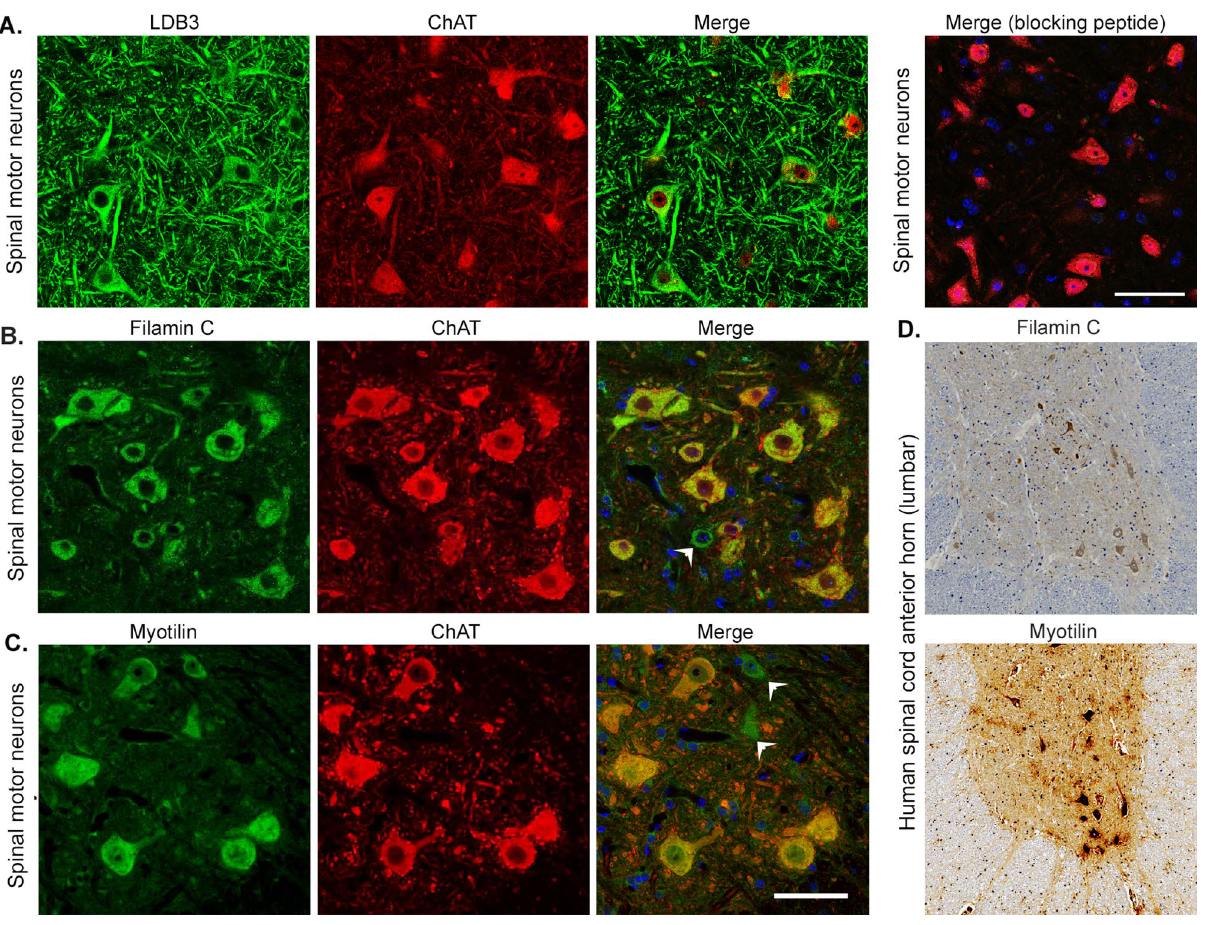
Figure 4. Immunolocalization of LDB3, filamin C and myotilin in spinal motor neurons. ( A ) Representative immunofluorescence on spinal cord lumbar cross section stained by GTX115593 antibody show LDB3 signal (green) in the cell body and processes of ChAT-positive (red) spinal motor neurons of six month old mice (n = 6). Addition of a blocking peptide results in loss of the LDB3 signal. ( B , C ) Immunostaining of parallel sections with antibodies against filamin C ( B ) and myotilin ( C ) detect both proteins in cholinergic neurons in the anterior horn of the spinal cord in mice (n = 6). Arrow heads indicate myotilin- and filamin C -antibody stained cells which are not ChAT positive. ( D ) Representative immunohostochemistry on human spinal cord lumbar segments (n = 3; 20 × magnification) show that neurons in the anterior horn react to the filamin C and myotilin antibody. Scale bar: 50